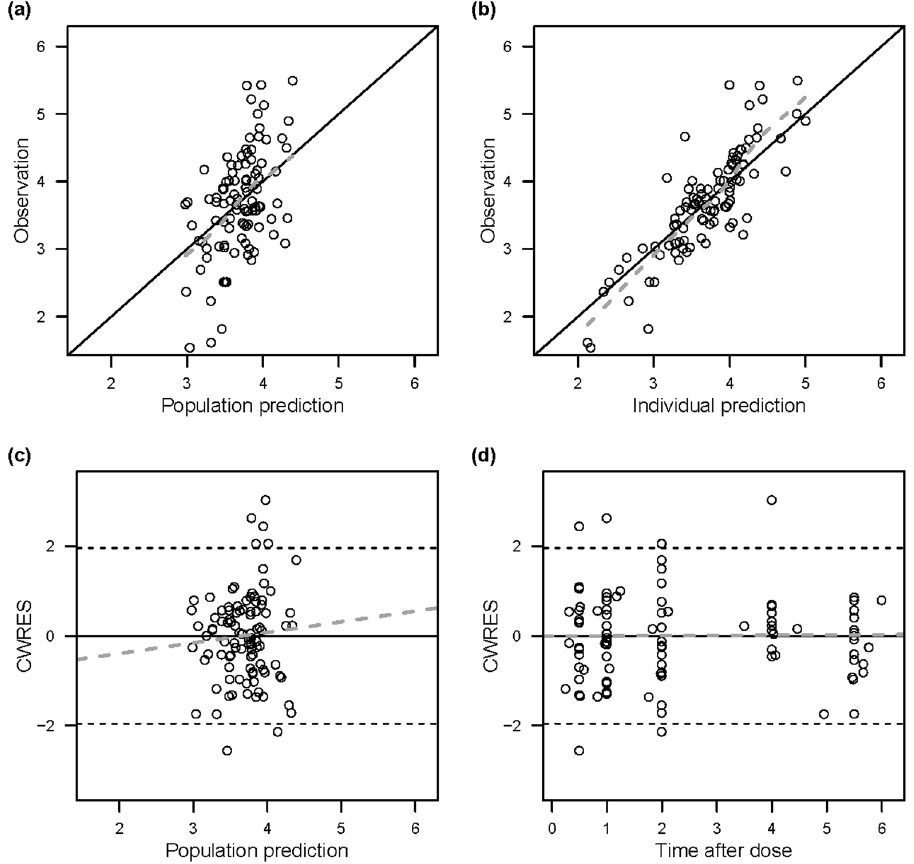
Figure 2. Goodness-of-fit plots for N-desmethyl sildenafil. ( a ) Population predictions versus observed concentrations; ( b ) Individual predictions versus observed concentrations; ( c ) Conditional weighted residuals (CWRES) versus population predictions; and ( d ) CWRES versus time. The solid lines represent the line of unity. The dashed lines represent the linear regression fit.